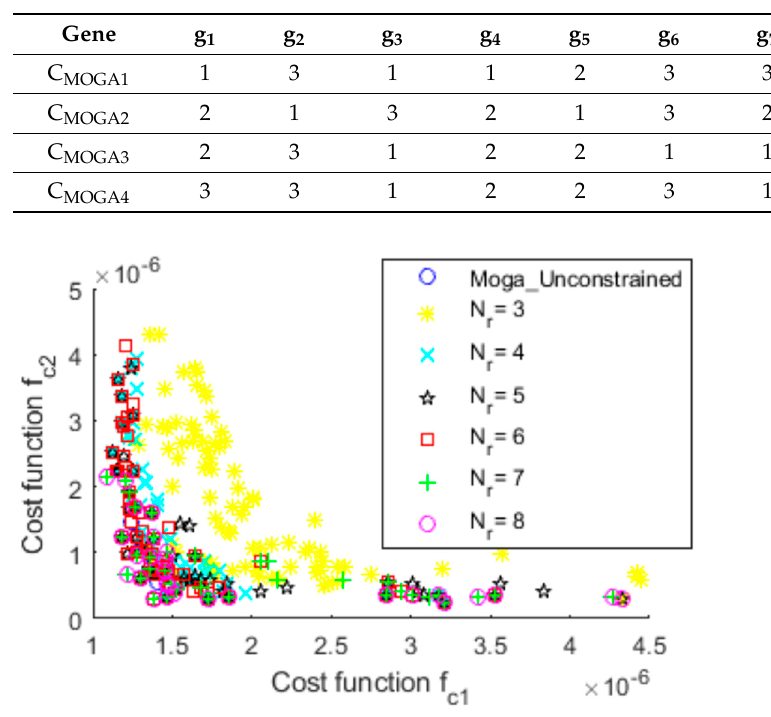
Figure 11. MOGA optimal solutions considering 100 runs for each of the constraints N r in the legend.